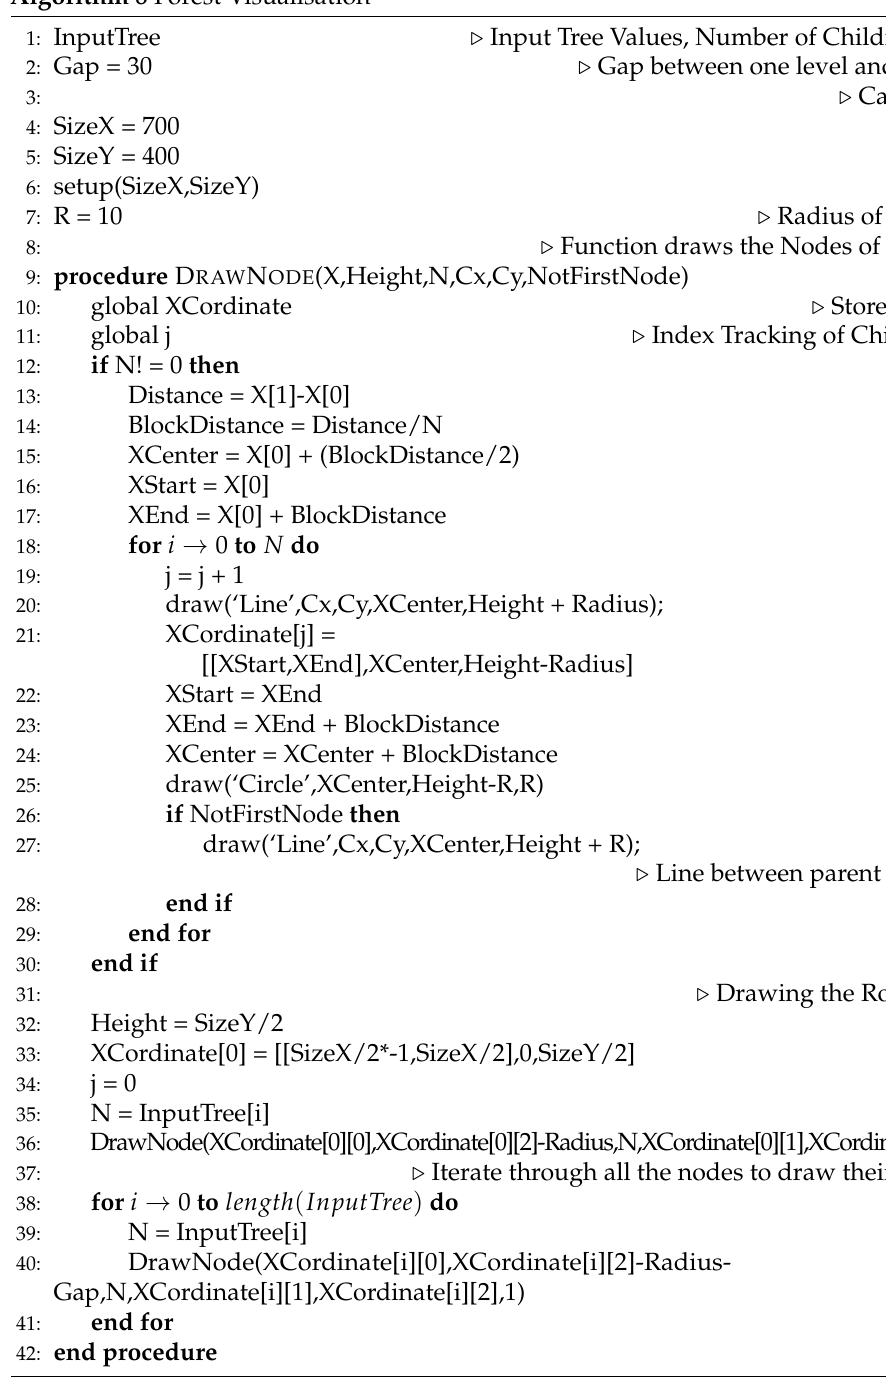
Algorithm 8 Forest